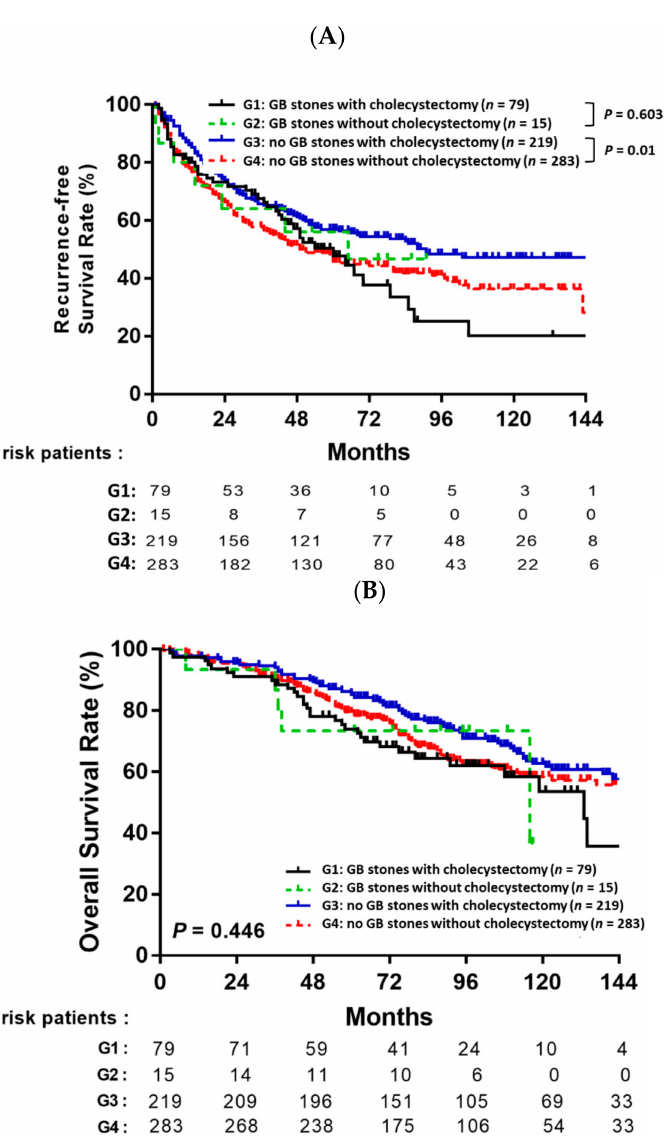
Figure 4. Recurrence-free survival ( A ) and overall survival ( B ) after resection for HCC patients stratified by the presence or absence of gallbladder stones and cholecystectomy or no